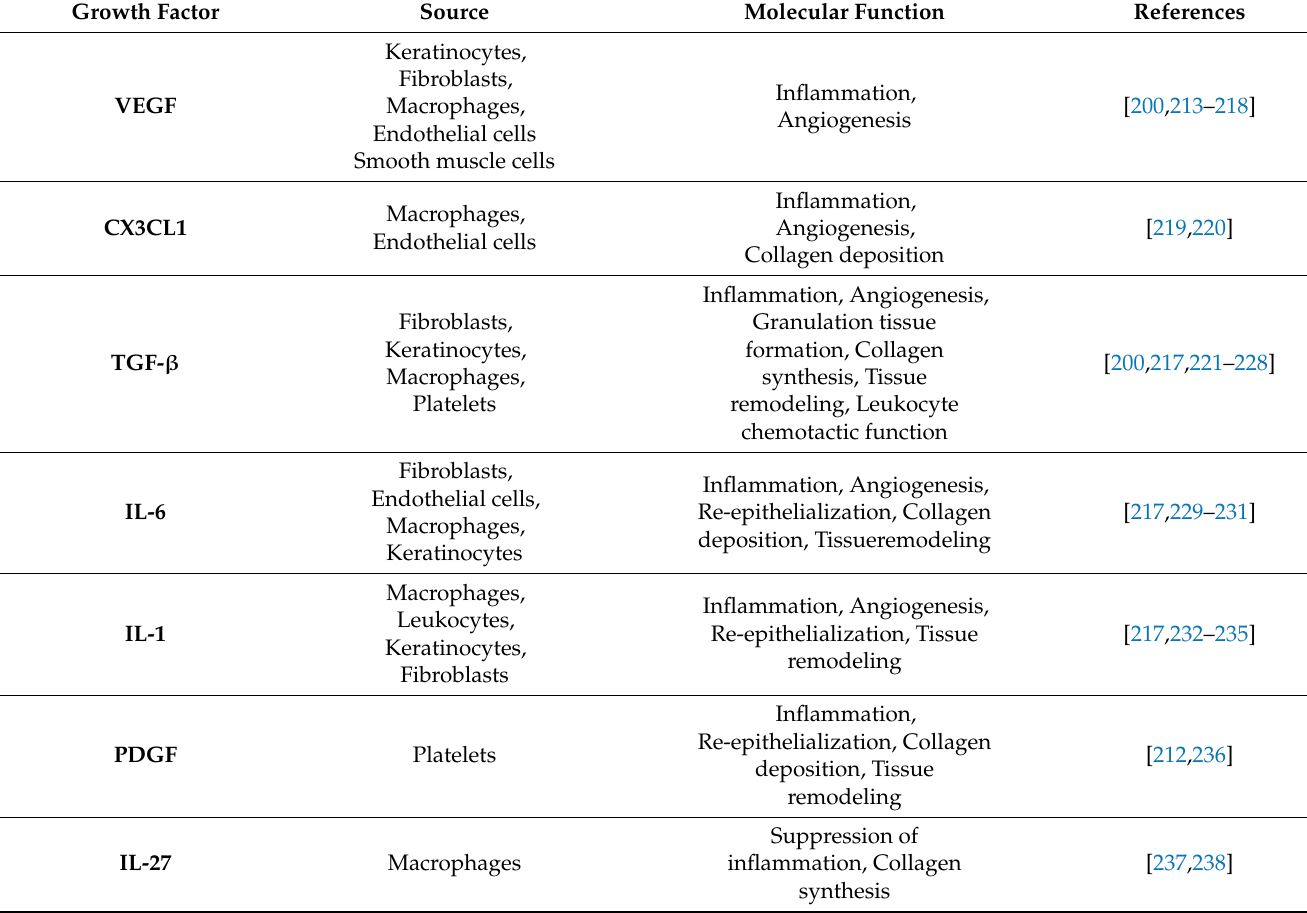
Figure 5. Phases of wound healing. The main events implicated during wound healing are hemostasis, inflammation, proliferation, and remodeling. (1) Hemostasis is the process of blood clotting and is the shortest phase in wound healing, lasting for only a few minutes. (2) The inflammatory phase comprises of blood coagulation, phagocytosis, removal of foreign bodies, and recruitment of growth factors and anti-inflammatory cells at the site of injury. (3) The proliferation phase encompasses fibroplasia, angiogenesis and cell migration, cell recruitment, re-epithelialization, and wound contraction. (4) Finally, in the remodeling phase, type I collagen replaces type III collagen in the wound site. Eventually, scar formation occurs through apoptosis. Table 6. Summary of major growth factors families and their applications in injury healing.